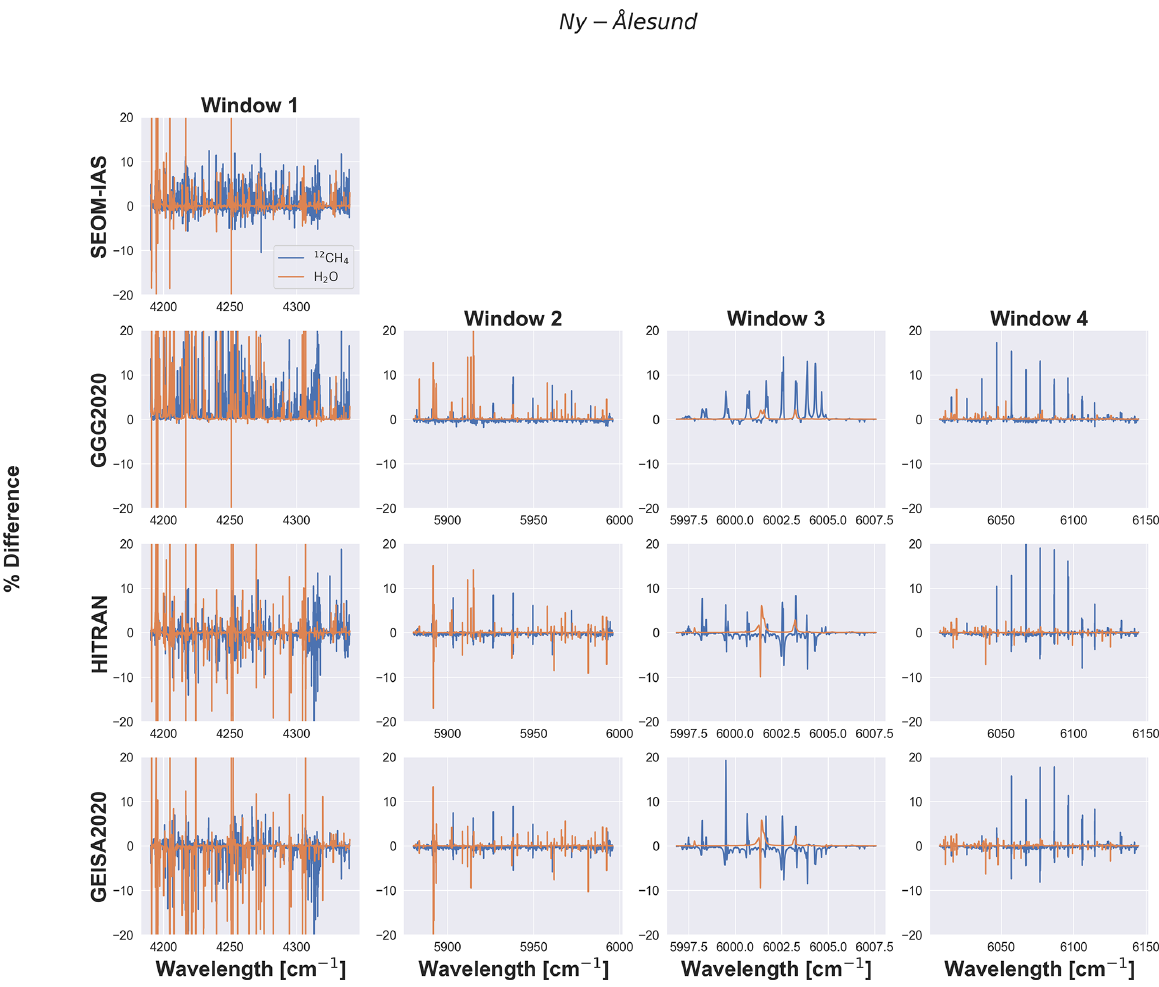
Figure 3. Percent difference in calculated transmission for 12 CH 4 and H 2 O from each spectroscopic database for each window with respect to GGG2014. Rows indicate the spectroscopic database, and columns indicate the windows. The y -axis values have been limited to 20% to avoid the plots being dominated by large excessive-noise values; note however, especially in window 1, the values are sometimes in excess of